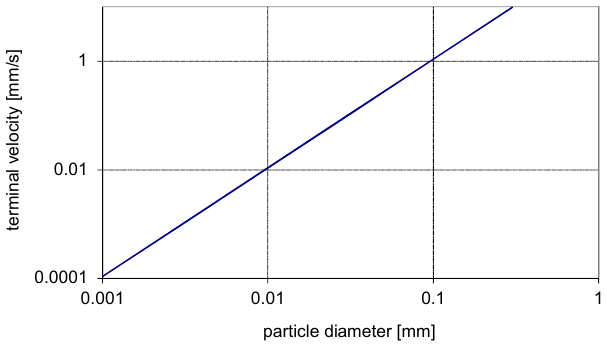
Figure 2: Particle terminal falling velocity as a function of particle size; (cid:85) s = 1200 kg/m 3 8 Figure 2. Particle terminal falling velocity as a function of particle size; ρ s = 1200kgm − 3 The critical shear stress for resuspension and the steady wall shear stress in a pipe with D = 9 0.1 m have been plotted in Figure 3, showing that the larger particles ( (cid:85) s = 1200 kg/m 3 en 10 d =25 (cid:80) m) will move if the water velocity U > 0.06 m/s. The critical shear stress for 11 resuspension increases linearly with the particle diameter and density, so that the critical 12 water velocity for other particles can be derived from Figure 3. 13